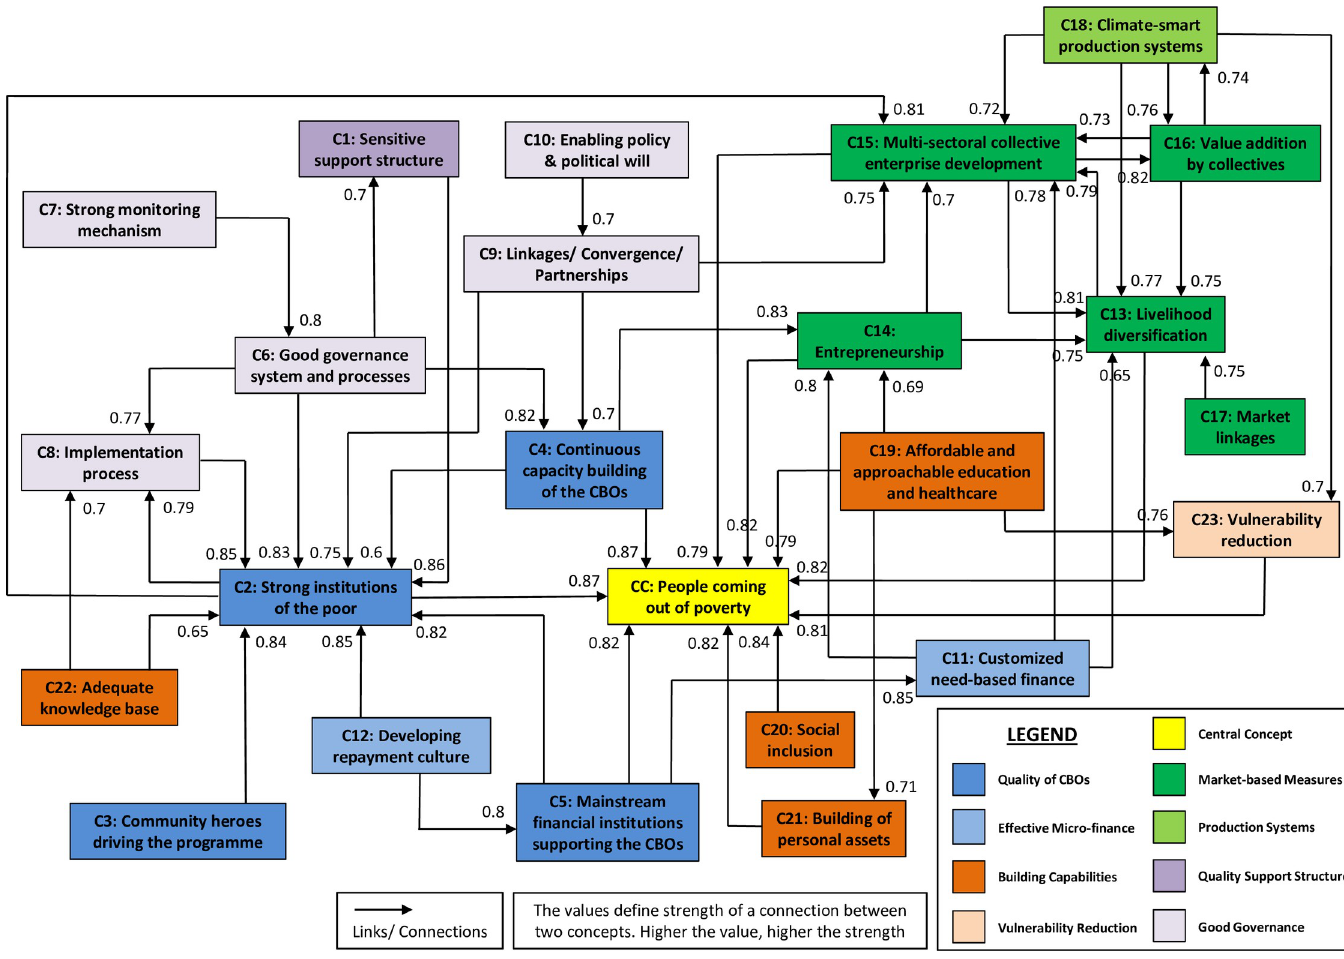
Fig 2. A social cognitive map showing the critical factors required for poverty